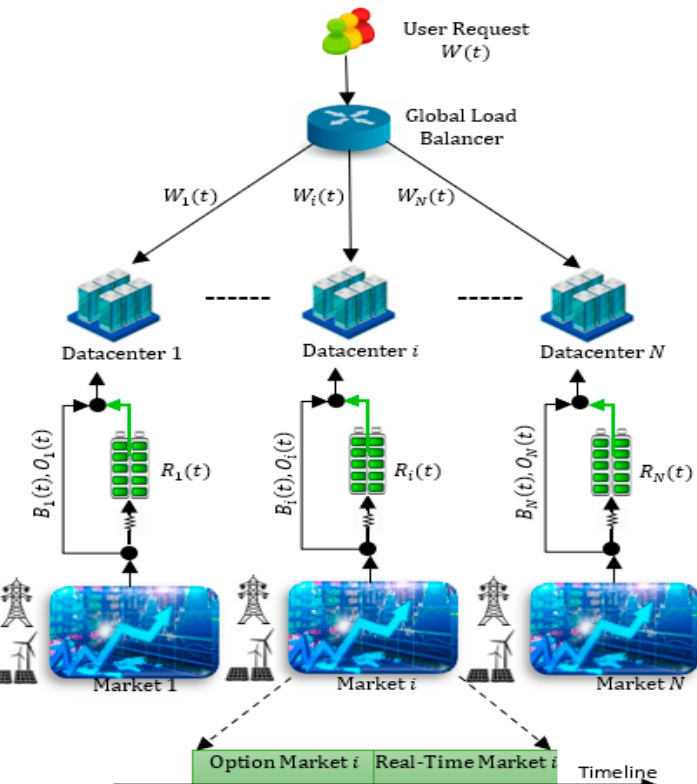
Figure 1. Data centers’ forwarding model for user requests.